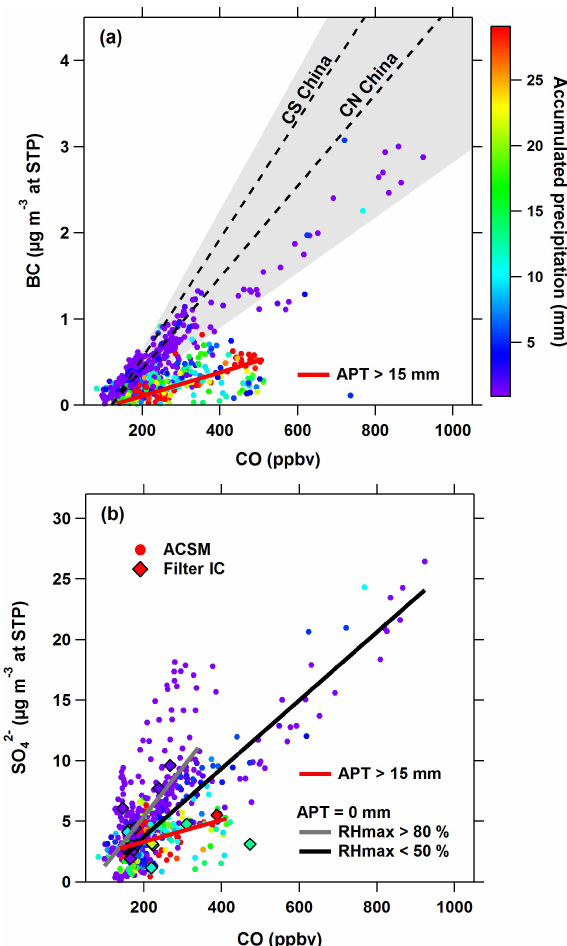
Figure 6. Correlation between aerosol mass concentrations and CO mixing ratio colored according to the APT. (a) BC measured by COSMOS and (b) SO 2 − measured by ACSM and IC (circles and 4 diamond markers, respectively). Dashed lines and shaded area in panel (a) represent the emission ratios of BC to CO over Central North and South (CN and CS) China and their variation ranges, respectively (Kanaya et al., 2016). The bold lines shown in pan- els (a) and (b) are the linear fitting to the BC–CO and ACSM- Figure 7. The (a) number and (b) mass size distributions of BC SO 2 − –CO correlations for the selected data points, i.e., those with 4 measured at Yokosuka (black markers) and at Fukue Island (gray the APT>15mm for BC and SO 2 − (red lines), those with the APT 4 markers). (c) The evolution of the peak D S and D core as a func- of 0 and RH max <50% for SO 2 − (black line), and those with the tion of the degree of removal of BC. The size distributions at Fukue 4 APT of 0 and RH max >80% (shaded line). Island include the data for the outflow air masses with (open mark- ers) and without (closed markers) BC loss. Lines in panels (a) and (b) are the lognormal fitting results. The shaded band in panel (b) corresponds to the size range analyzed to estimate D S /D core ratios. Vertical lines in panel (b) represent the peak D core of the lognormal fit for each of three mass size distributions. Note that the peak D core of lognormal fit for the BC number–size distributions at Yokosuka was estimated from the peak D core of its mass size distribution (Ta- ble 2). The peak values of D S and D core shown in panel (c) were determined by fitting the lognormal function to the hourly number and mass size distributions of BC-containing particles,